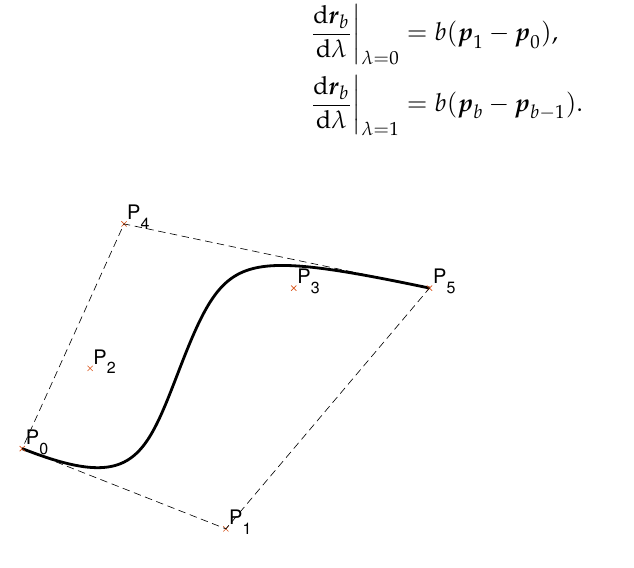
Figure 1. Fifth order Bernstein–Bézier curve within its convex hull (dashed lines). The curve is tangent to the sides of the convex hull, line segments P 0 P 1 and P 4 P 5